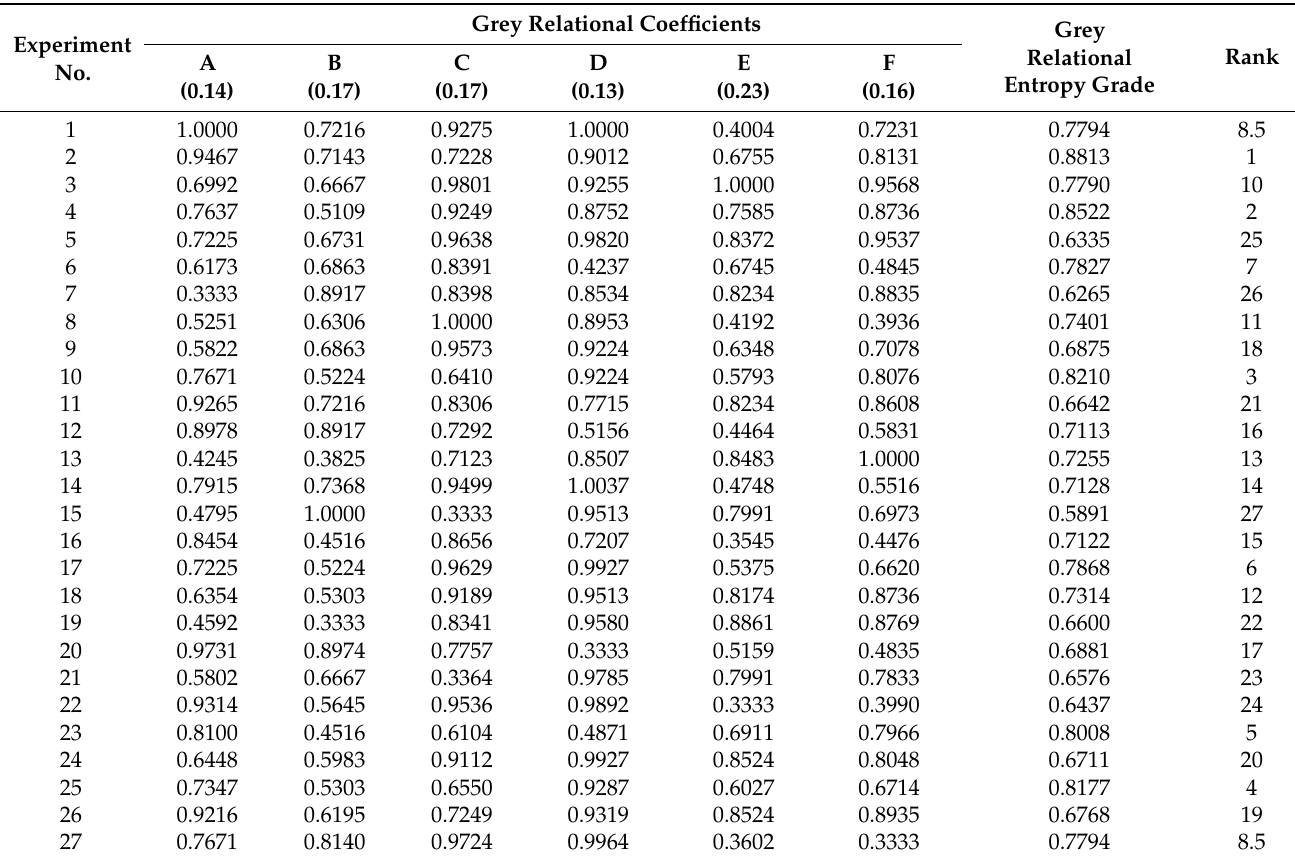
Table 7. Grey Relational Coefficients with entropy-based weights, Grey Relational Grade and rank for the various test